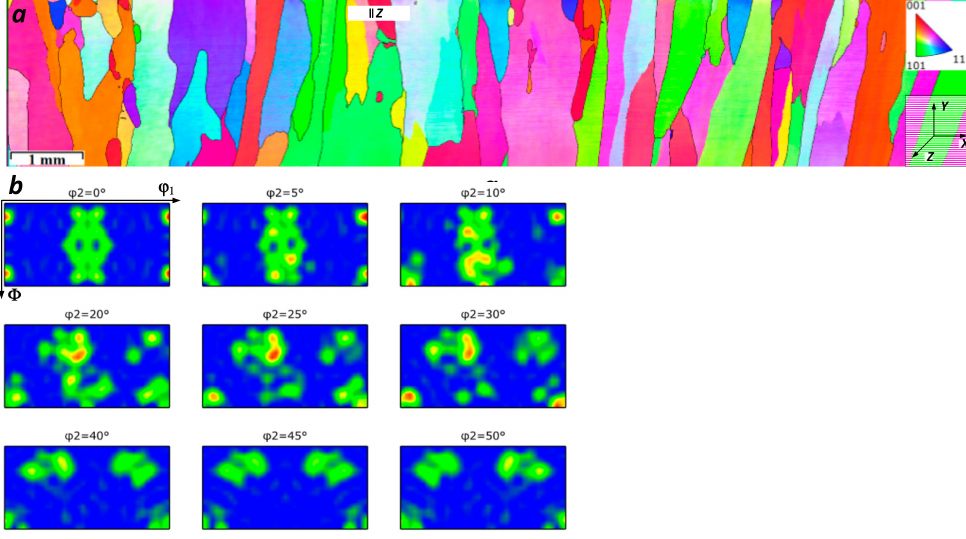
Figure 8. Grain orientation map ( a ) and ODF ( b ) for as-grown sample